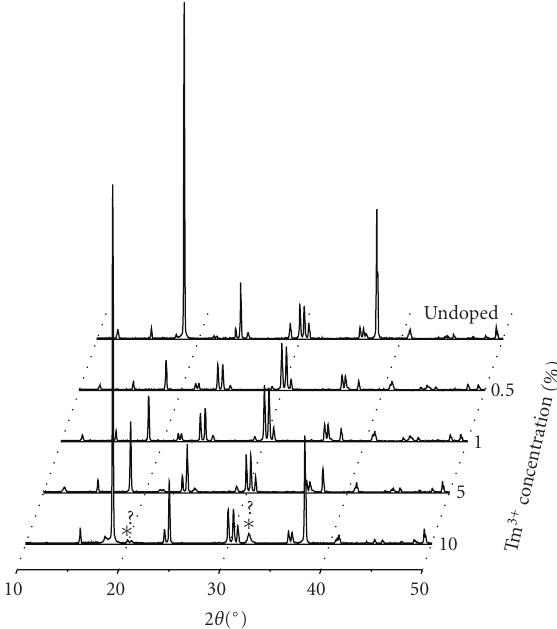
Figure 1: XRD patterns of LiIn 1 − x Tm x (WO 4 ) 2 ( x = 0, 0.5, 1, 5, and 10